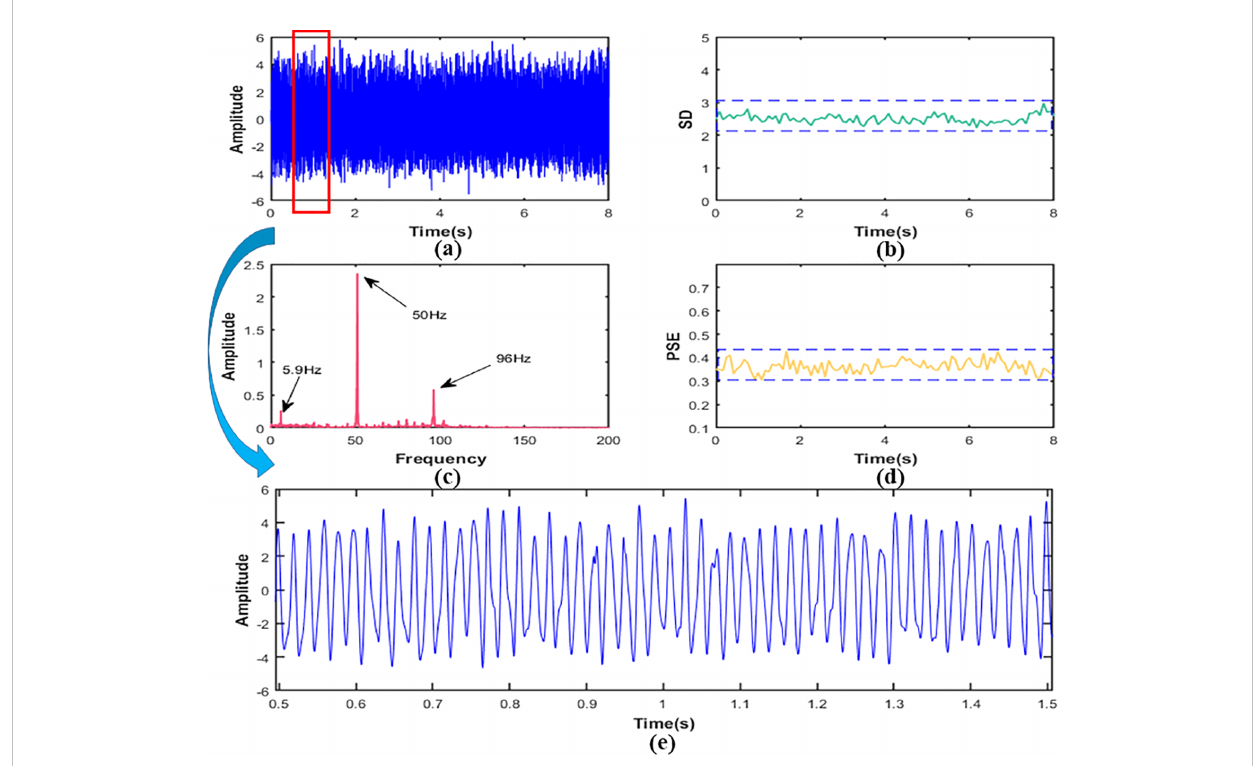
FIGURE 9 In working condition S2, signal (A) time domain fi gure, (B) the SD, (C) the PSE, (D) the FFT, (E) local ampli fi cation fi